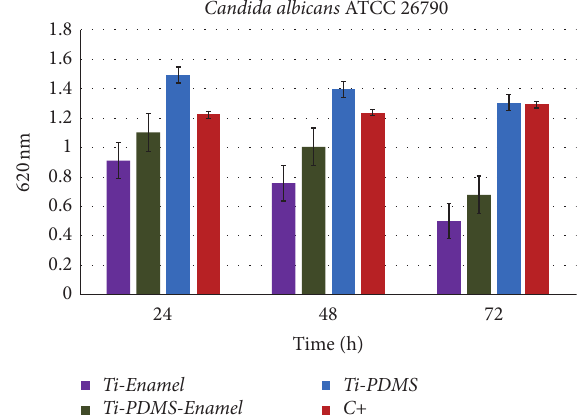
Figure 5: Graphical representation of the absorbance values of